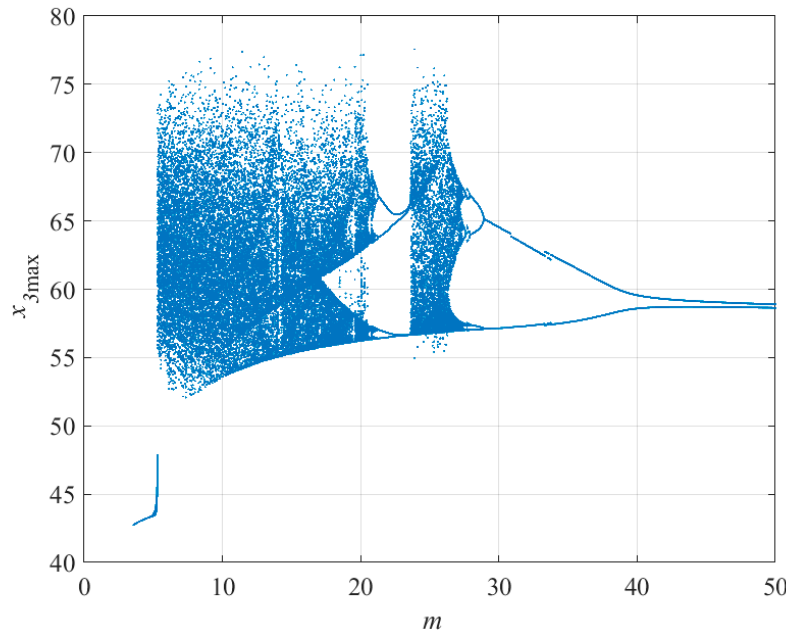
Figure 5. Bifurcation diagram of proposed fractional-order system by changing parameter 𝑚.